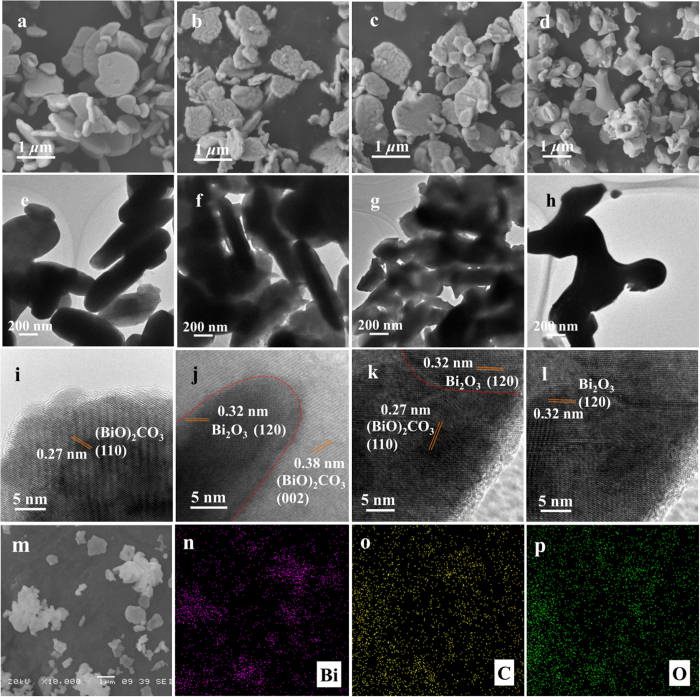
Morphological characterization of the as-prepared samples.(a–d) SEM, (e–h) low-magnification, and (i–l) HR-TEM images of (BiO)2CO3, BOC-400, BOC-450, and Bi2O3, respectively. (m) SEM image of BOC-450 heterojunction and the corresponding (n–p) elemental X-ray mapping for bismuth, carbon, and oxygen elements.